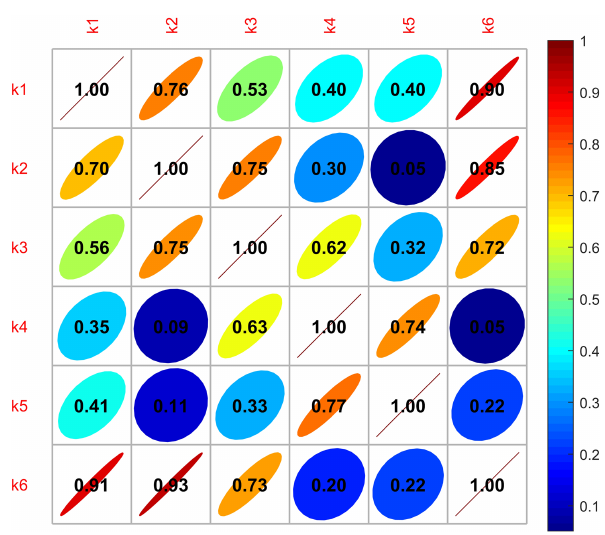
Figure 7. Fitting accuracy between the objective